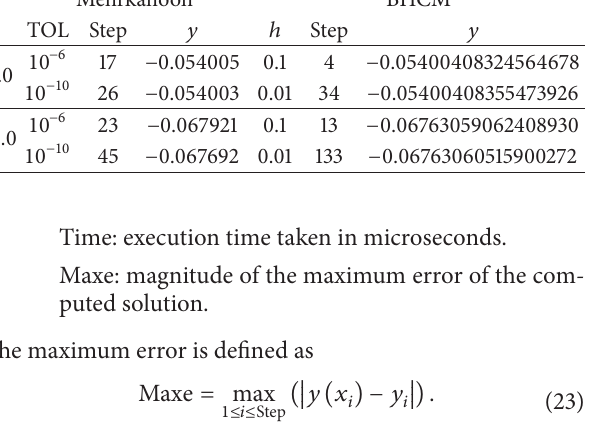
Table 4: Comparison of numerical results for nonlinear Genesio equation. 𝑏 Mehrkanoon